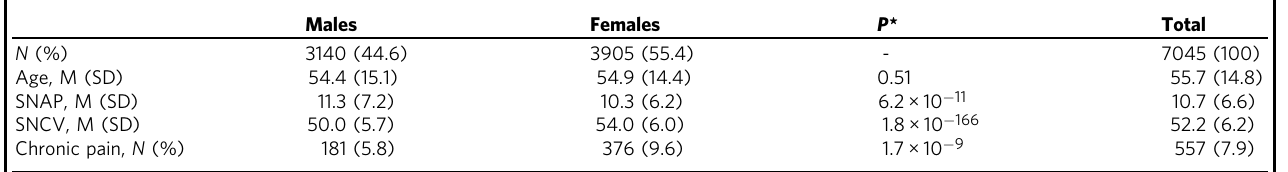
Table 1 Demographics and descriptive statistics for the GWAS sample, N = 7045 Males